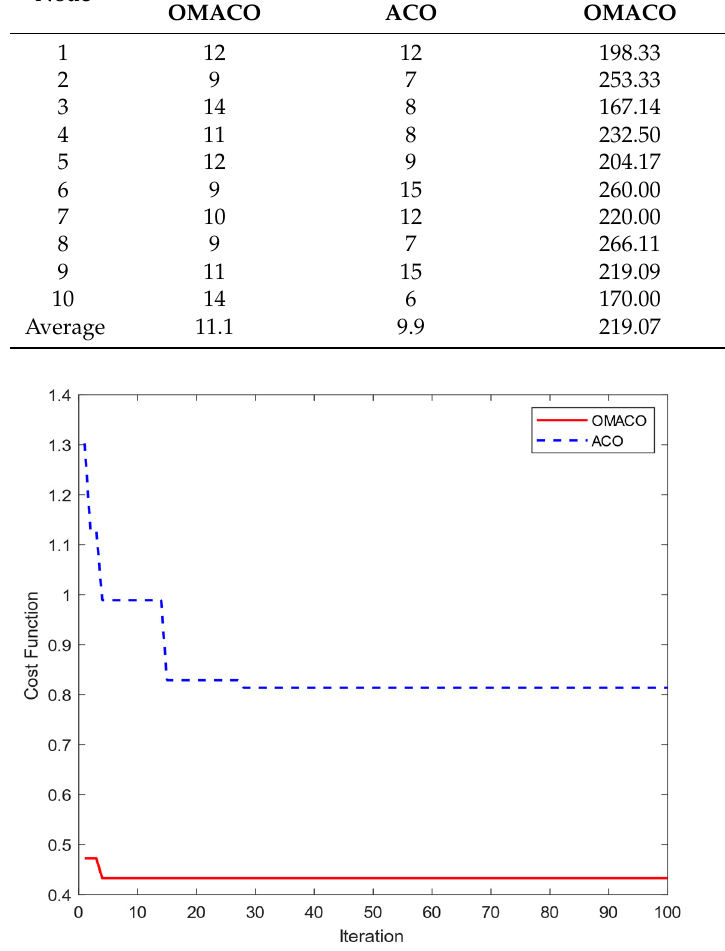
Figure 8. The objective function iteration curves of the two algorithms.